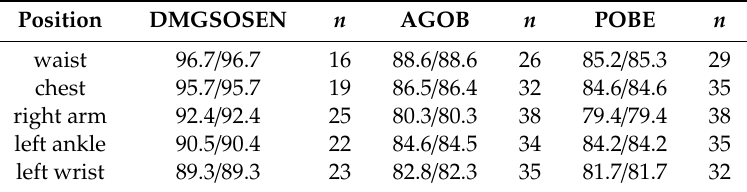
Table 15. Performance comparison (Accuracy / F1%) and number of ELMs after pruning achieved by comparative algorithms.